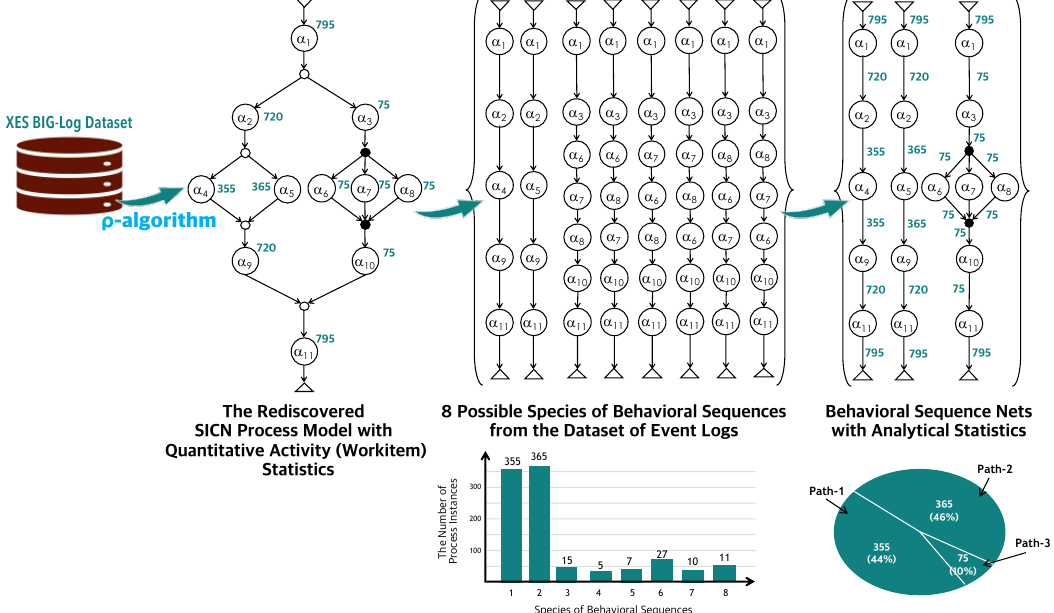
Figure 6. The behavioral analysis and statistics of the rediscovered process